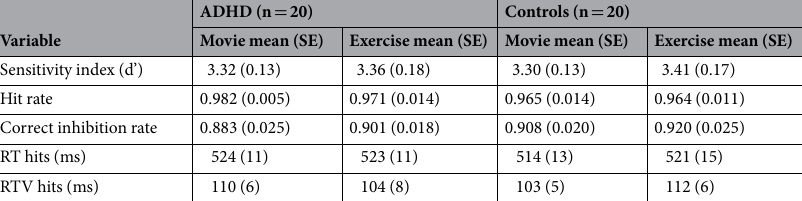
Table 2. Behavioral performance during the Go/No-go task for each group and condition. RT = reaction time; RTV = reaction time variability; SE = standard error of the